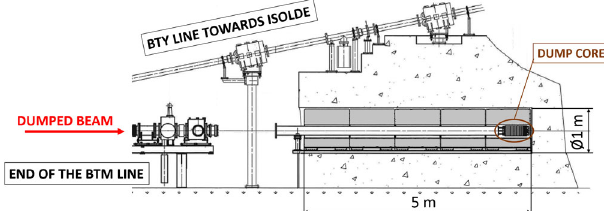
1. Drawing of the original PS booster dump core, showing the side and front view of the assembly. Dimensions are reported in mm.